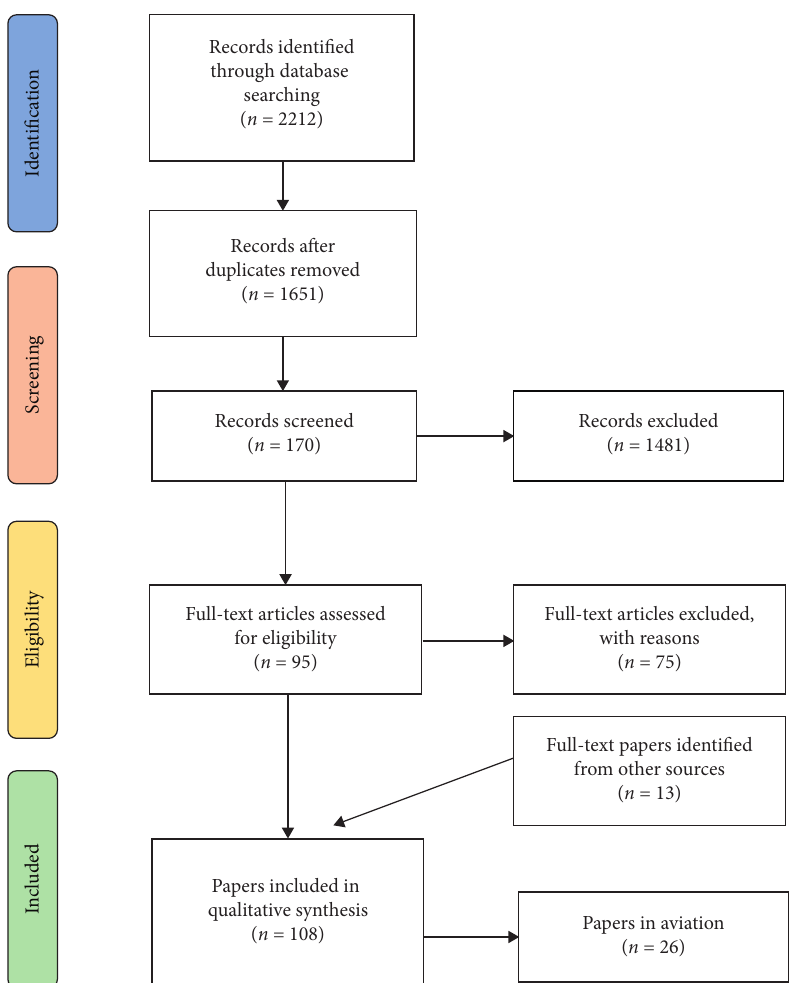
Figure 3: The literature identified and screened is presented as a PRISMA flowchart diagram (the 26 aviation papers were included in the total 108 papers included in the qualitative